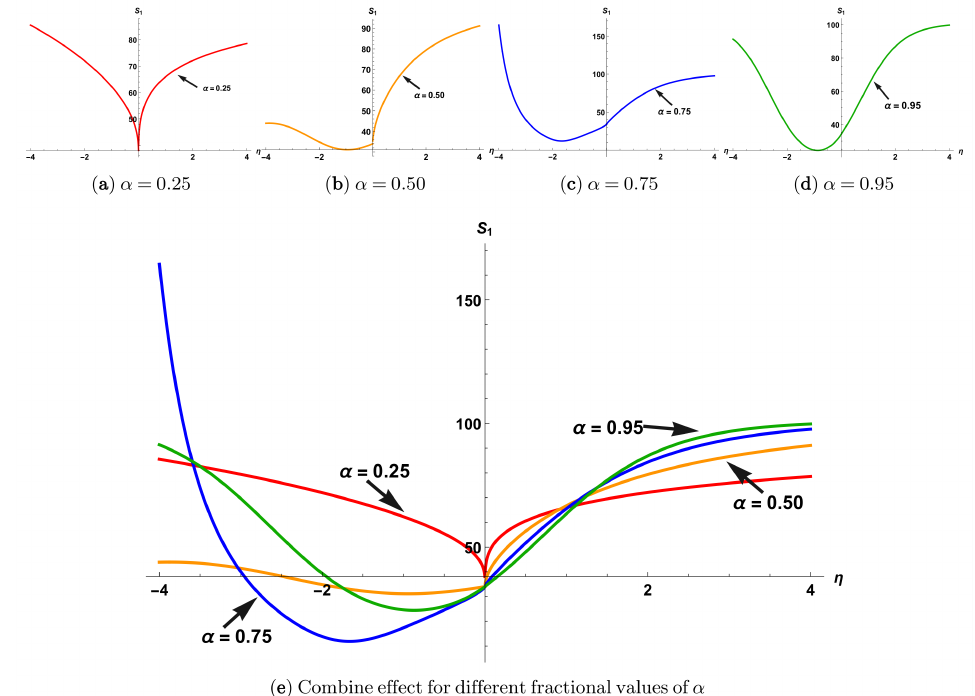
Figure 2. A 2D graphical representation for S 1